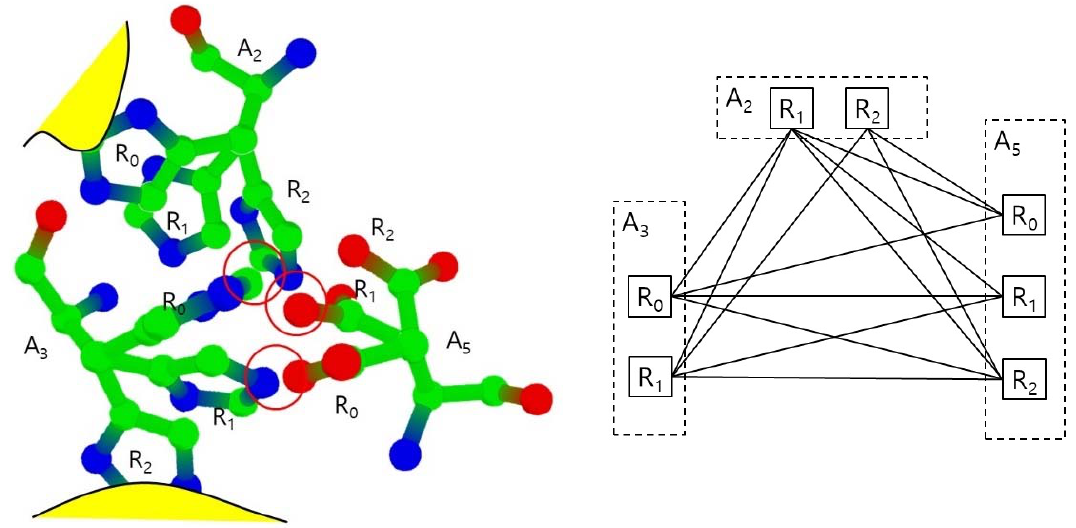
Figure 4. Collisions between rotamers ( left ) and the corresponding collision free graph ( right ).